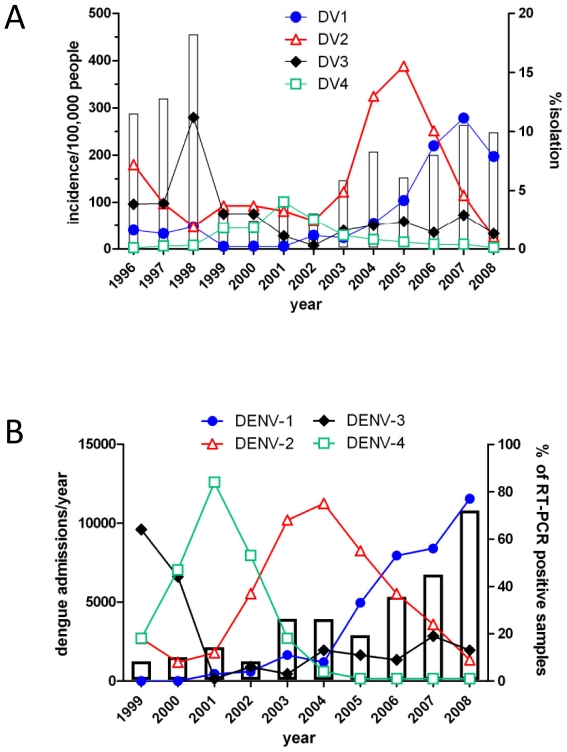
Fluctuations in dengue incidence and serotype abundance in southern Viet Nam.
A) Changes in the incidence of hospitalized dengue cases (left-hand axis, open bars) and the relative virus prevalence (right hand axis) between 1996 and 2008 in the southern 20 provinces of Viet Nam. Data is from the Vietnamese Ministry of Health Dengue passive surveillance scheme and kindly provided by the Pasteur Institute, HCMC, Viet Nam. B. Case burden (left-hand axis, open bars) and DENV serotype prevalence detected by RT-PCR in children and adults (n = 3463 RT-PCR positive patients) enrolled into clinical studies at the Hospital for Tropical Diseases, Ho Chi Minh City between 1999 and 2008. The Hospital for Tropical Diseases is a tertiary referral hospital for infectious diseases. The values underneath the graph represent the number of RT-PCR positive samples each year.